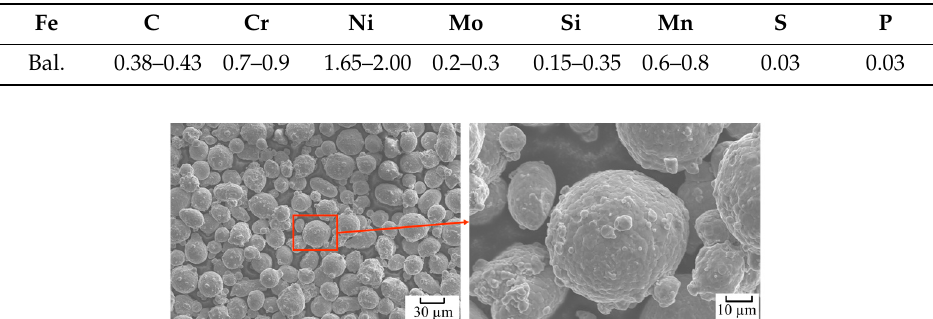
Figure 4. SEM micrographs of the 4340 powder at two different magnifications.